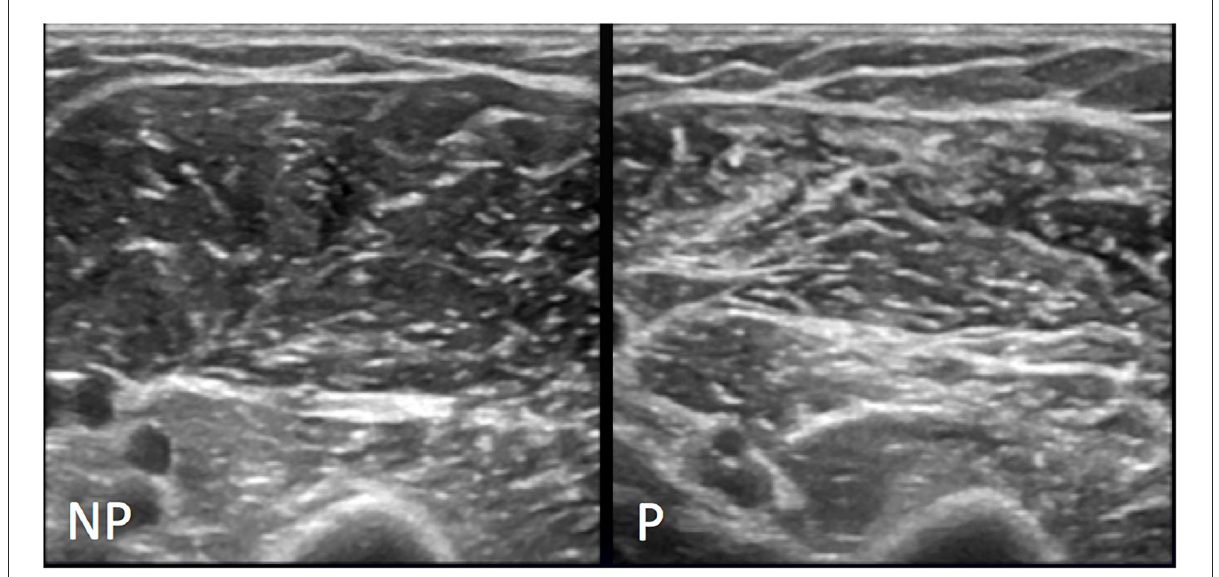
FIGURE8 Representative MHS grade II. Conventional US appearance of biceps brachii and brachialis muscles on non-paretic (NP) and paretic side (P) following stroke, as assessed with the axial US scans: on the left image normal US appearance of muscle with regular echogenicity of fibers and normal muscular fibers—intramuscular septa differentiation; the right image shows volume reduction of muscle and increase in background echogenicity with intramuscular septa more represented and still